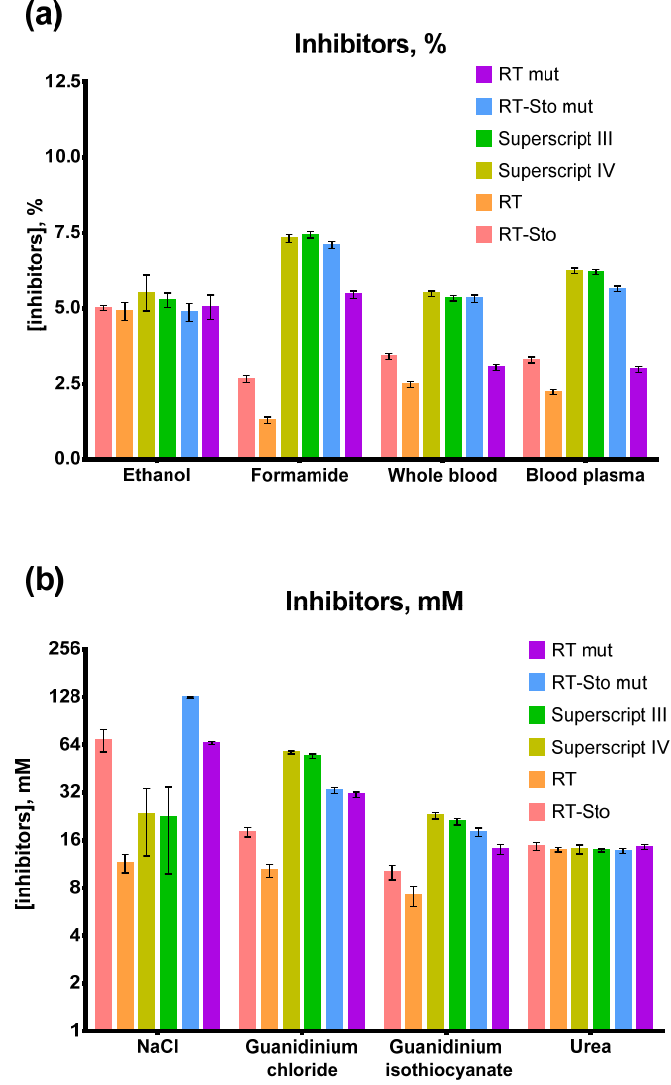
Figure 6. RT-LAMP with various inhibitors. Substances tested as inhibitors in RT-LAMP: ( a ) ethanol, formamide, human whole blood, and human blood plasma; ( b ) NaCl, guanidinium isothiocy- anate, guanidinium chloride, and urea. The temperature of the reverse transcription step was 55 °C